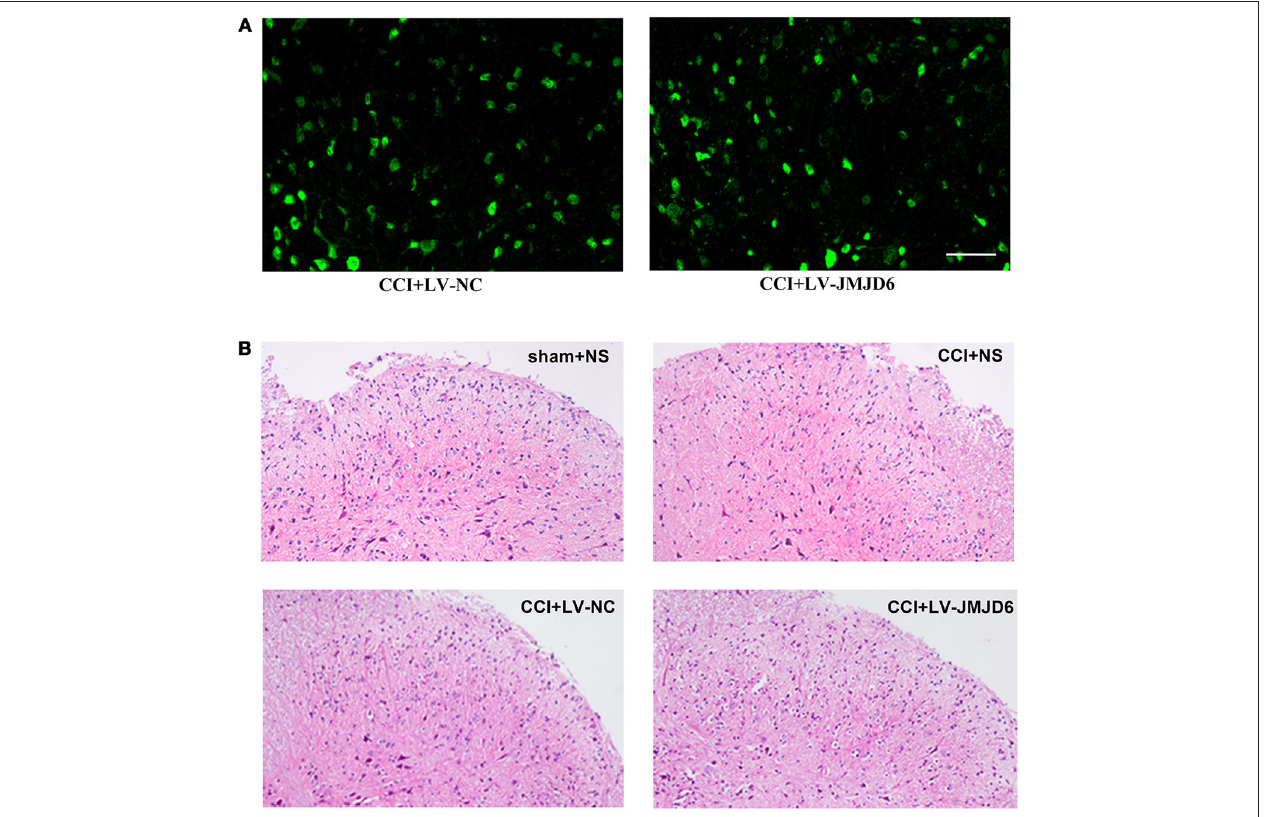
FIGURE 3 | Successful intrathecal injection of lentiviral vectors. (A) Representative images of GFP (green) in the spinal dorsal horn of rats that received LV-NC or LV-JMJD6 lentiviral vectors. Scale bars = 50 µ m. (B) H&E staining showing the histopathology of the spinal cord following intrathecal catheter insertion and vector injection. Sham + NS, the left sciatic nerve was only exposed + intrathecal injection with 0.9% saline. CCI + NS, CCI surgery + intrathecal injection with 0.9% saline. CCI + LV-NC, CCI surgery + intrathecal injection with LV-NC. CCI + LV-JMJD6, CCI surgery + intrathecal injection with LV-JMJD6.